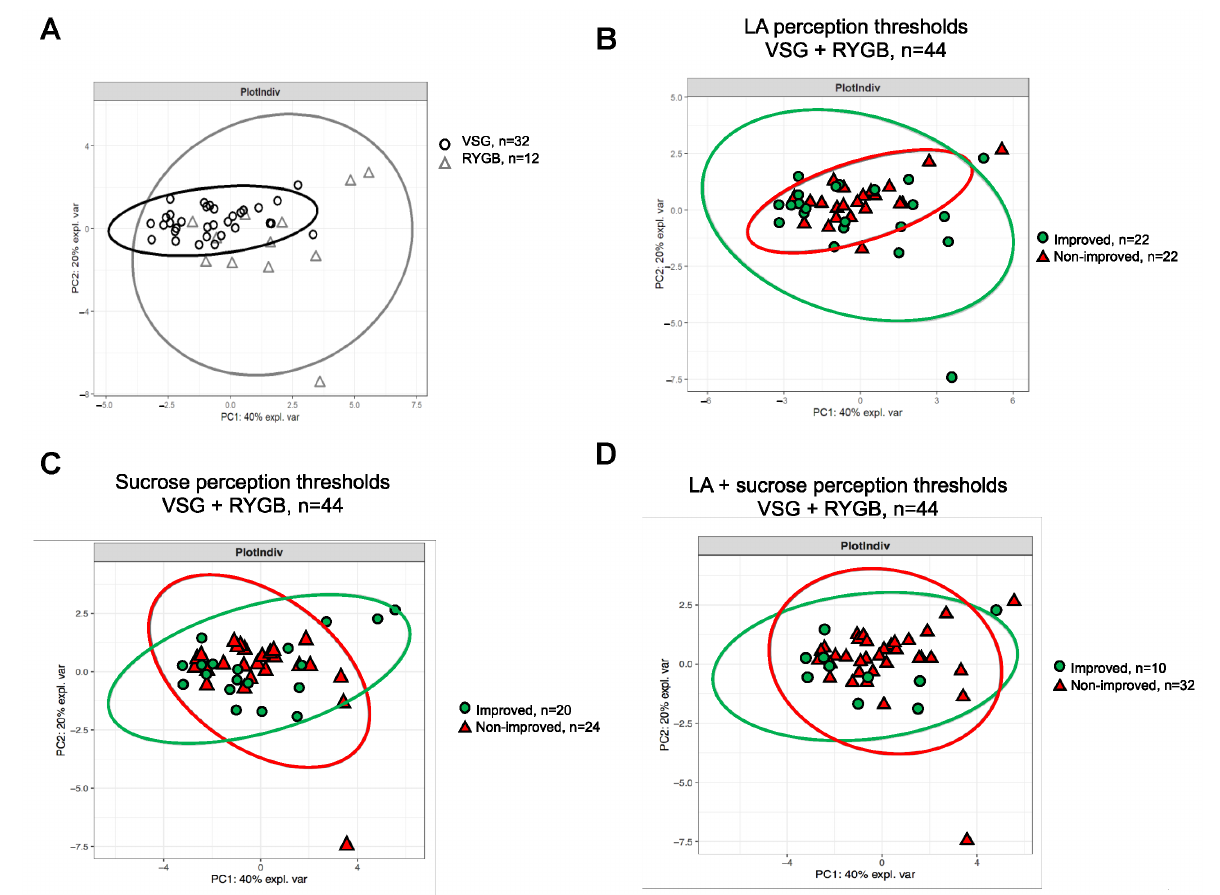
Figure 5. Principal component analysis (PCA) of gut hormones (i.e., insulin, GLP-1, PYY and Ghrelin) response to a test meal 6 months after surgery, as well as confidence ellipse analysis. ( A ) Comparison of VSG and RYGB patients. ( B ) Comparison of patients (VSG + RYGB) with and without improvement (improved vs. nonimproved) of the LA perception threshold. ( C ) Comparison of patients (VSG + RYGB) with and without improvement (improved vs. nonimproved) of the sucrose perception threshold. ( D ) Comparison of patients (VSG + RYGB) with and without improvement (improved vs. nonimproved) of the LA+ sucrose perception